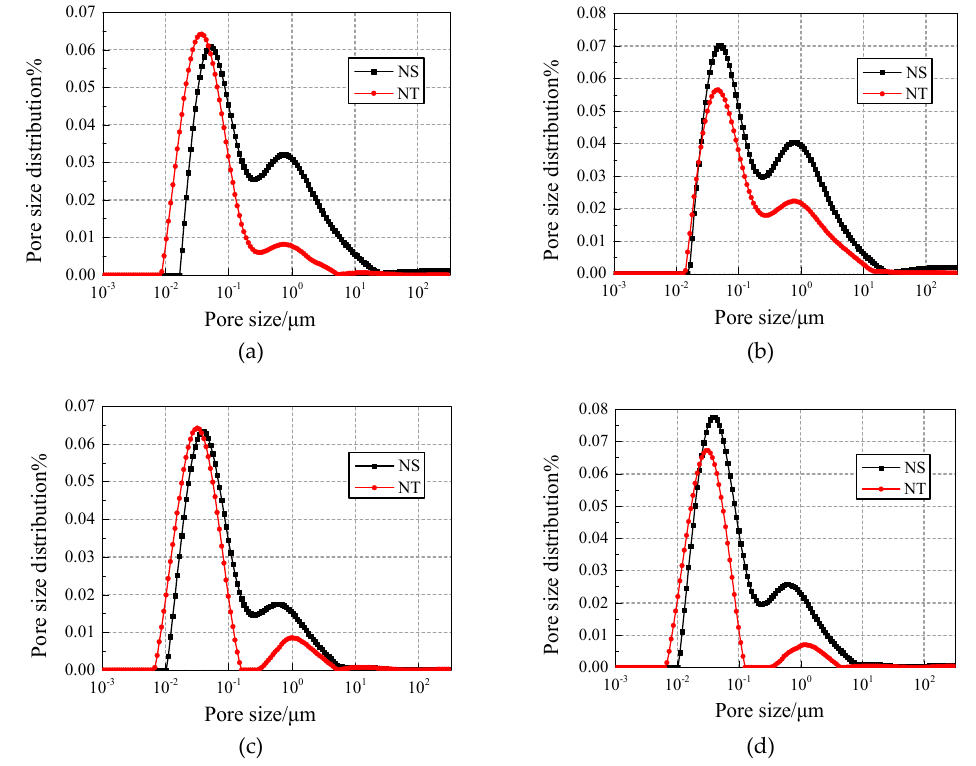
Figure 13. Comparison of pore fluid size distribution of NS/NT added concrete under 50 freezing and thawing cycles. ( a ) Content of 0.2%; ( b ) Content of 0.4%; ( c ) Content of 0.6%; ( d ) Content of 0.8%.